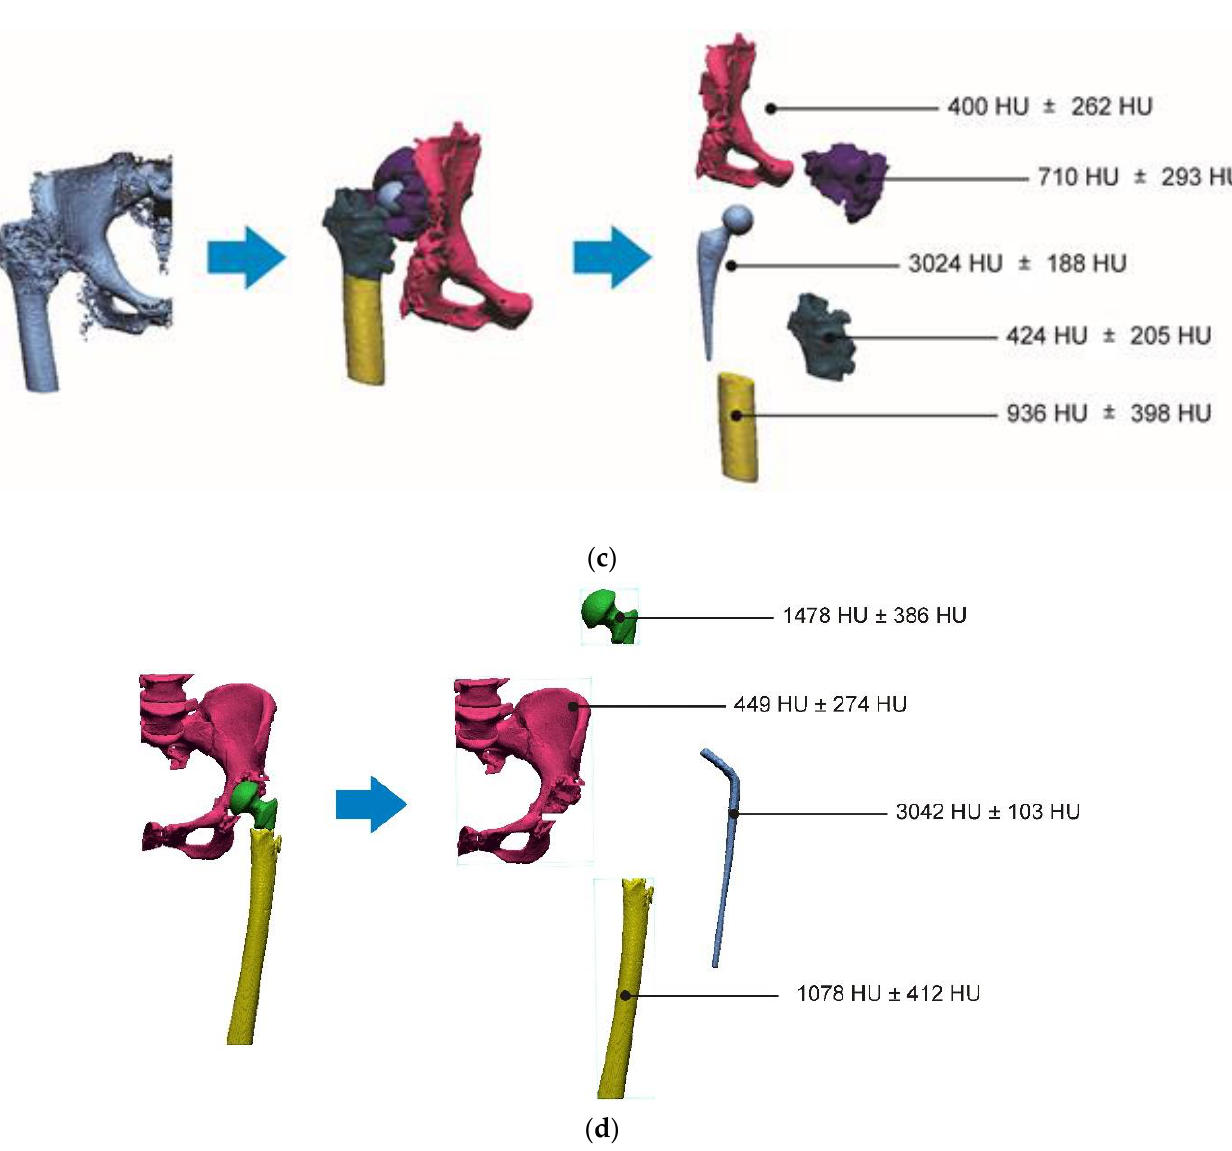
Figure 7. Improving the segmentation process with the application of the local threshold as exemplified by: ( a ) Bone structures within the area of the hip joint and the knee joint with the implant — Patient No. 2; ( b ) Bone structures within the area of the knee joint — Patient No. 5; ( c ) Bone structures within the area of the hip joint with the implant and the bone cement — Patient No. 7; and ( d ) Bone structures within the area of the hip joint with the implant — Patient No. 10.